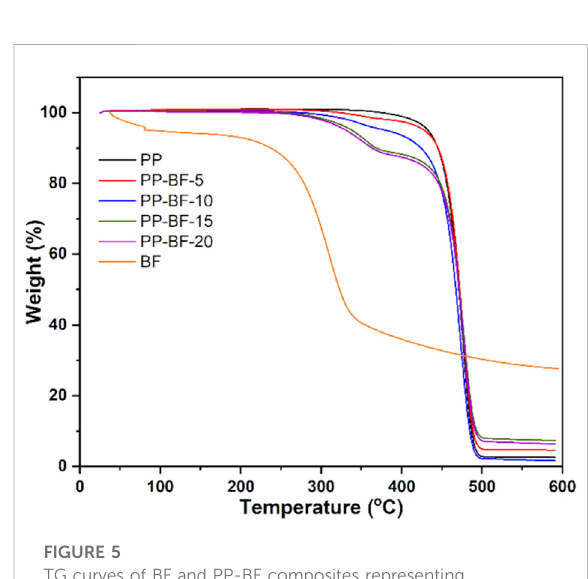
FIGURE 5 TG curves of BF and PP-BF composites representing percentage weight loss with temperature.